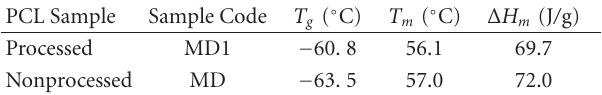
Table 4: Thermodynamics characteristics of PCL during second heating